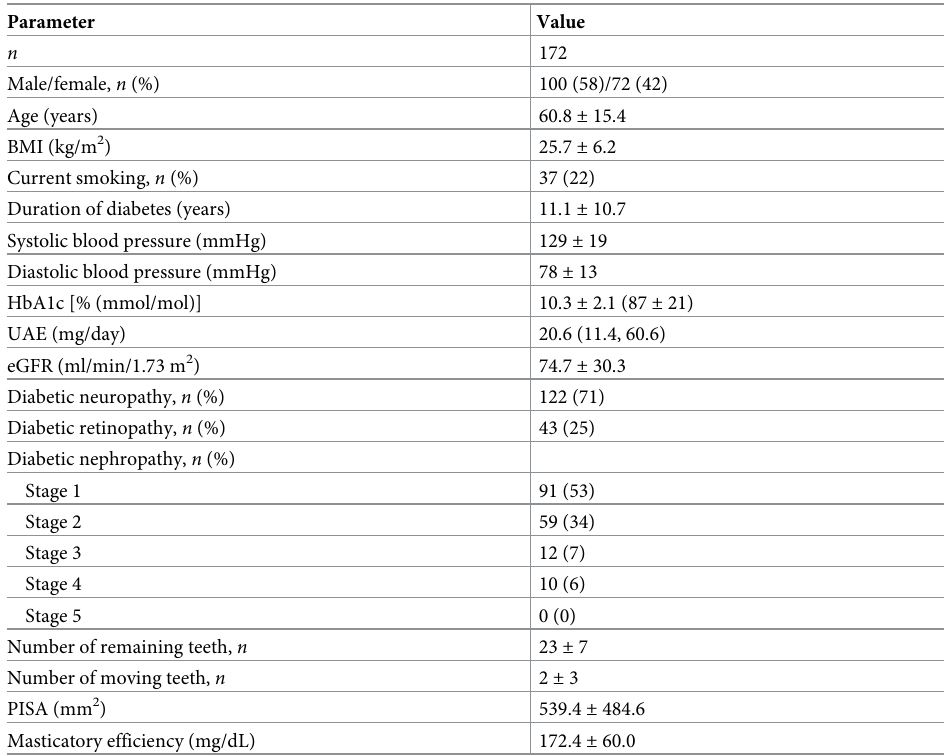
Table 1. Participant characteristics at